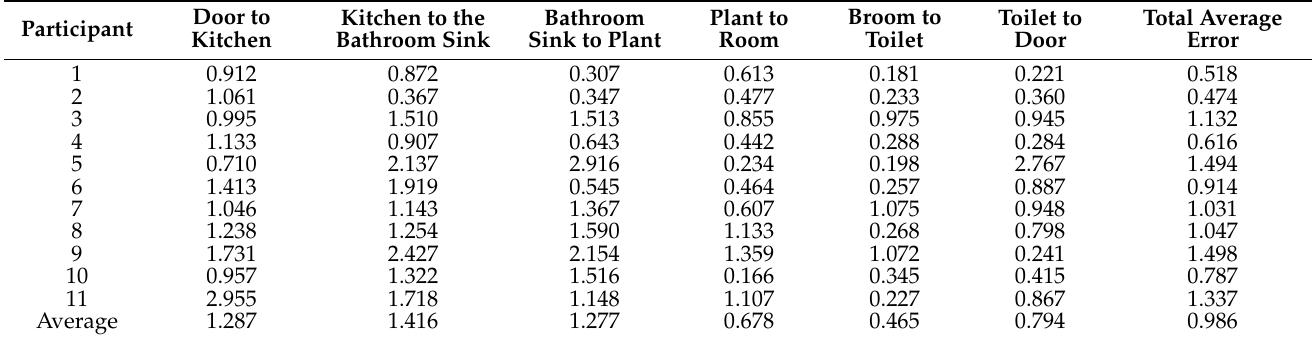
Table 7. Average error (in meters) of the location for each sub-trajectory (Control